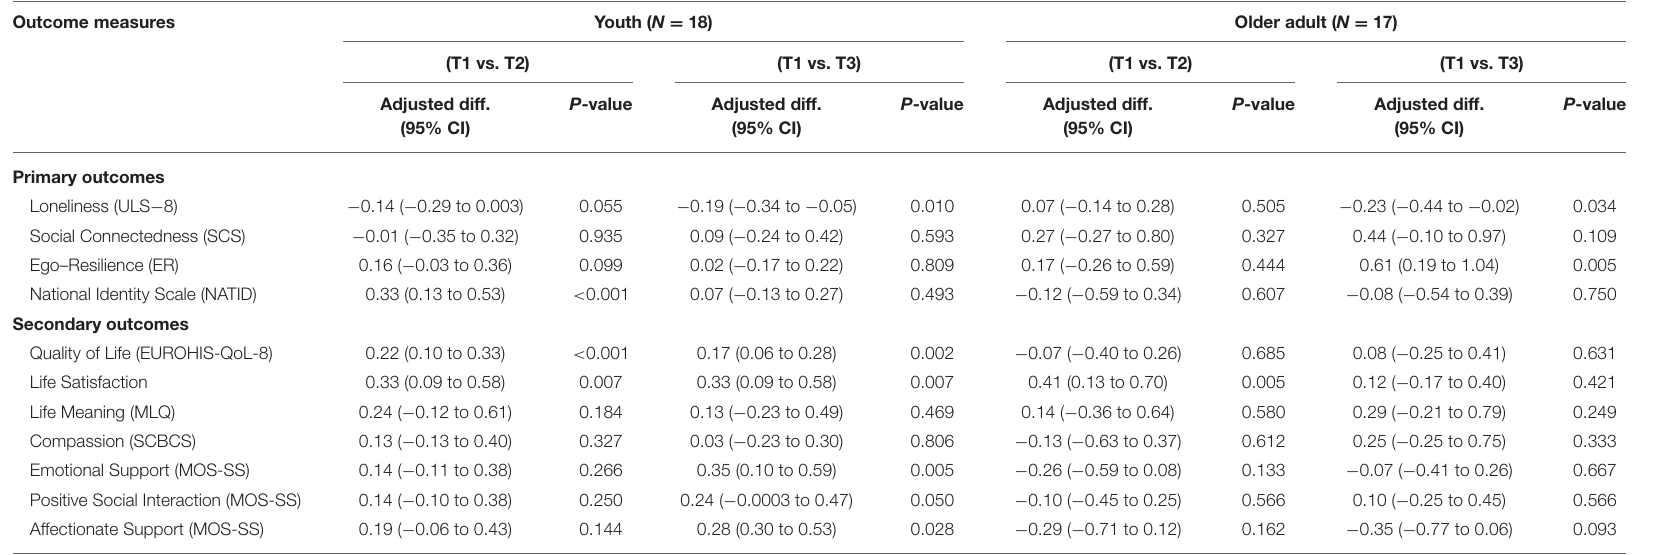
TABLE 5 | Separate subgroup analysis for youth and older adults in intervention group only using linear mixed models. Outcome